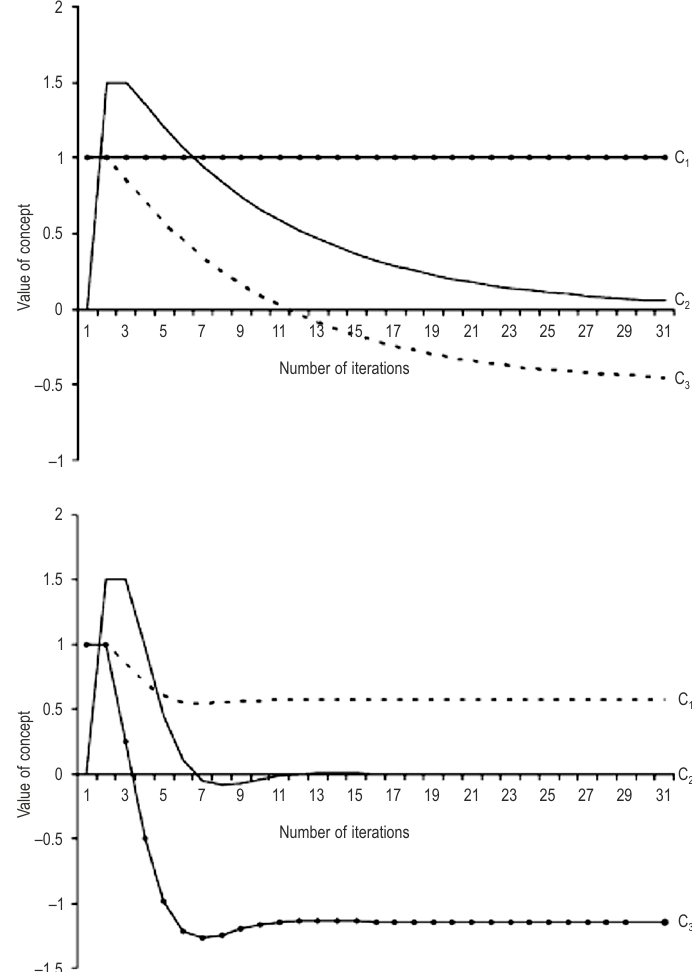
Figure 3. FCM stabilization and value convergence points Source : Kok (2009: